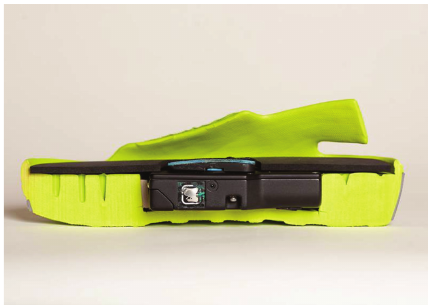
Figure 3: A lateral cross-section of the MMC sandal showing the embedded compression device in the sole. The pressure pad is in the retracted